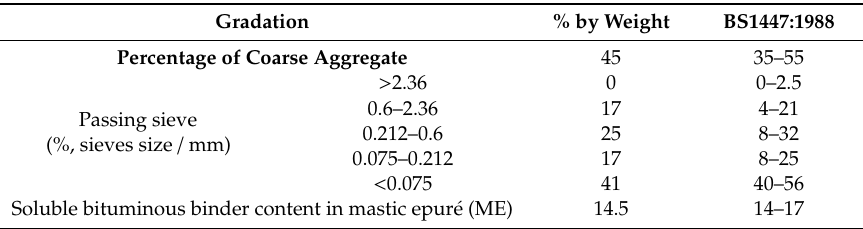
Table 3. Gradation of MA